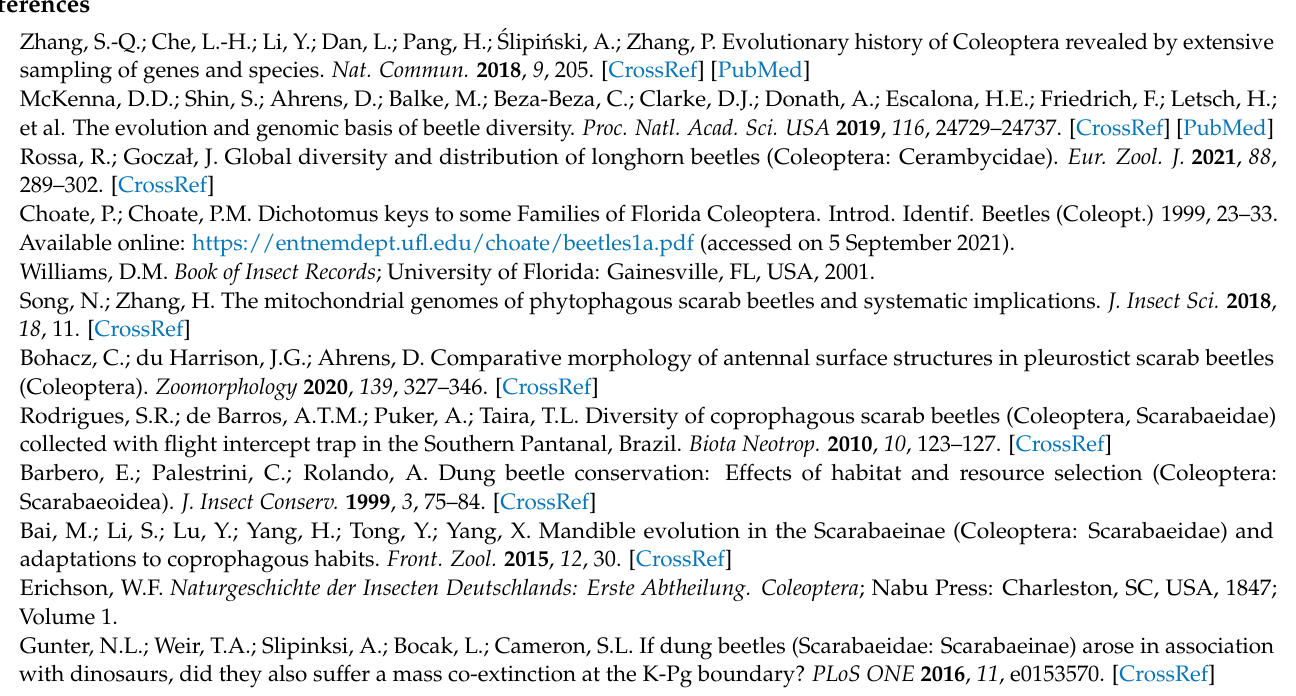
between trnK and trnD from all sequenced Dynastinae insects. Figure S3. The relative synonymous codon usage (RSCU) in each Cetoniinae and Dynastinae species mitogenomes. Codon families are provided on the x -axis and the different combinations of synonymous codons that code for each amino acid is defined on the y -axis. Table S1: The partition schemes and best-fitting models selected of 13 mitochondrial PCG and AA. Table S2. Location of features in the mitochondrial genome of Cetoniinae (A) and Dynastinae species (B). Table S3. Nucleotide composition and skewness of the whole mitogenomes of Cetoniinae and Dynastinae species. Table S4. Base composition, the percent of A, C, G and T, AT skew and GC skew of nucleotide sequence of 13PCGs of Cetoniinae and Dynastinae species. Table S5: NCR1 and NCR2 sequences in Dynastinae species. NCR = Non-coding Region. Table S6. Nucleotide composition and skewness of the A-T rich region of Cetoniinae and Dynastinae species. Table S7. Characteristics of the putative tandem repeats in the control region of Cetoniinae and Dynastinae species mitogenome. Table S8. Total number of codons, codon frequency and usage for each amino acid of mitochondrial genome of Cetoniinae and Dynastinae